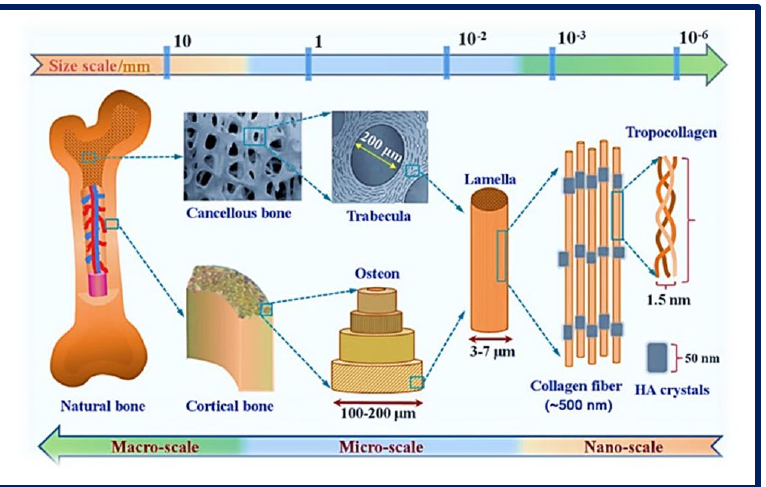
Figure 5. Complexity of an organ showing its macro, micro, and nanoarchitecture. Chemical com- position and multi− scale structure of natural bone. Bibliography consulted [35] is licensed under CC BY 2.0. To view a copy of this license, visit http://creativecommons.org/licenses/by/4.0/, (accessed on 15 December 2022).